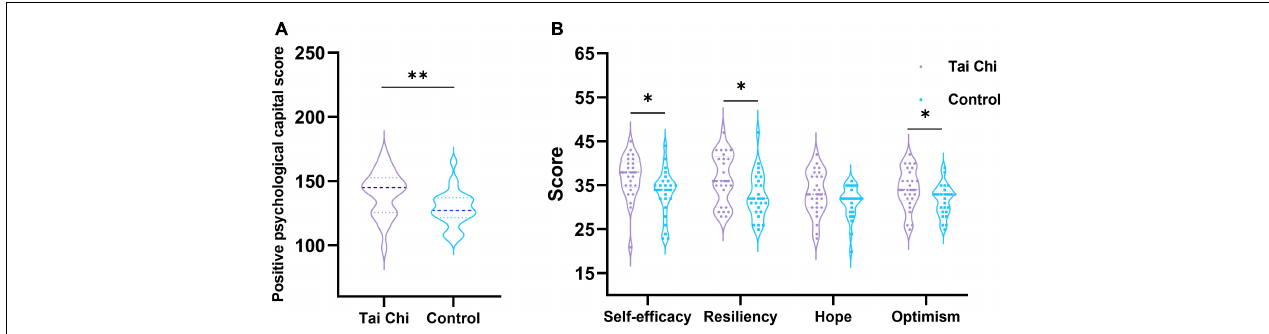
FIGURE 1 | Analysis of psychological questionnaire scores in TC group and control group. (A) The score difference of positive psychological capital questionnaire between groups. (B) Inter group score difference of four core components. ∗ Indicated significant difference between groups, p < 0.05, ∗∗ indicated significant difference between groups, p <